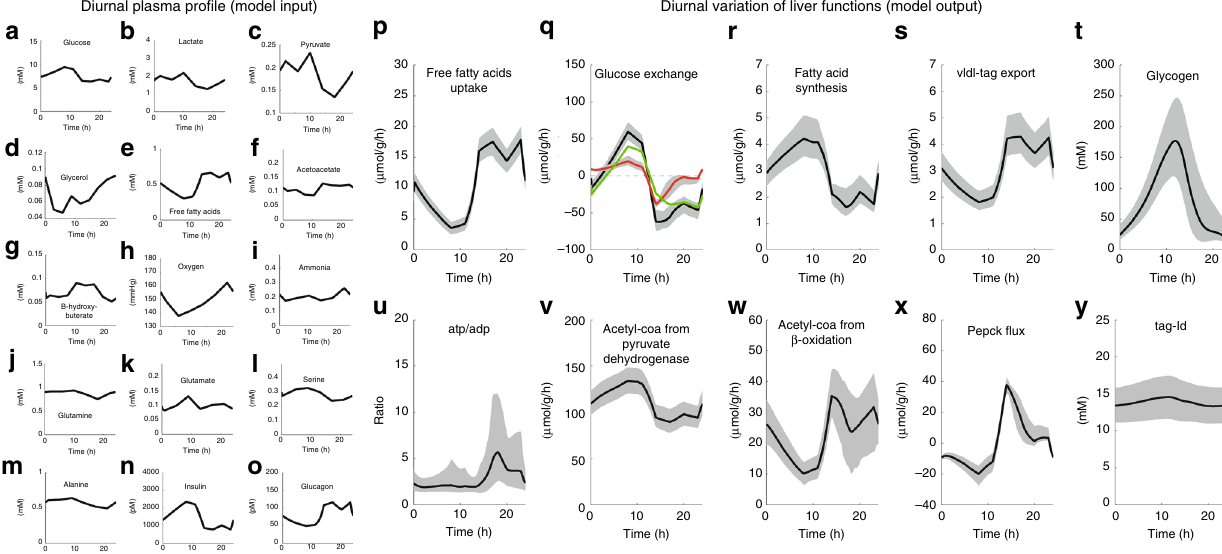
Fig. 3 Simulated diurnal changes of selected metabolic functions of a normal rat liver. Left panels: 24 h plasma pro fi le of hormones and metabolites of an ad libitum fed rat serving as model input. a glucose, b lactate, c pyruvate, d glycerol, e free fatty acids, f acetoacetate, g β -hydroxy butyrate, h oxygen, i ammonia, j glutamine, k glutamate, l serine, m alanine, n insulin, o glucagon. Right panels: Simulated diurnal pro fi le of 10 selected metabolic functions ( = model output). p uptake of free fatty acids, q glucose exchange, r fatty acid synthesis, s triglyceride export by VLDL, t glycogen content, u ATP/ADP ratio, v rate of pyruvate dehydrogenase ( = entry of glucose carbons into the citric acid cycle), w rate of β -oxidation ( = entry of fatty acid carbons into the citric acid cycle), x rate of PEPCK, y triglyceride content. The green and red curves in q represent the rate of glycolysis/gluconeogenesis and glycogen synthesis/degradation ( = fl ux through the phosphoglucomutase). Note that negative exchange fl uxes indicate net release from the liver to the plasma. Gray areas around the solid curves encompass 95% of values obtained in 100 recurrent simulations where the V max value of each enzyme was randomly sampled from an interval between 90 and 110% of the reference value